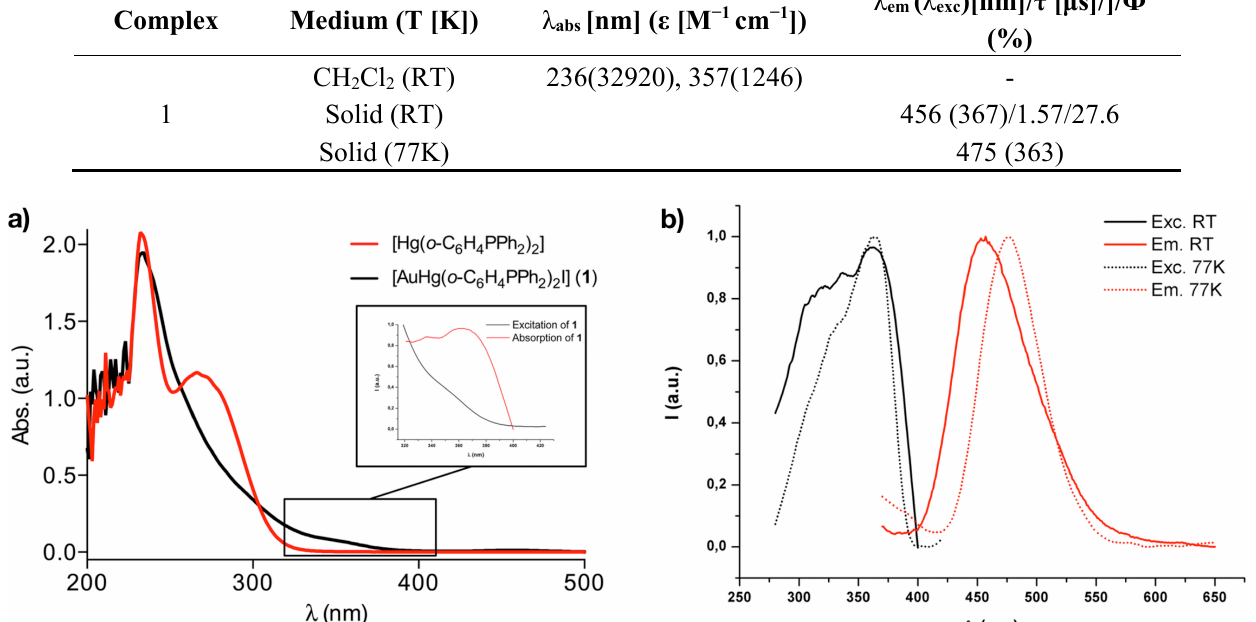
Table 2. Photophysical properties of [AuHg( o -C 6 H 4 PPh 2 ) 2 I] ( 1 ).